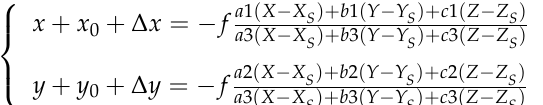
Figure 2. Positioning of binocular stereo cameras.